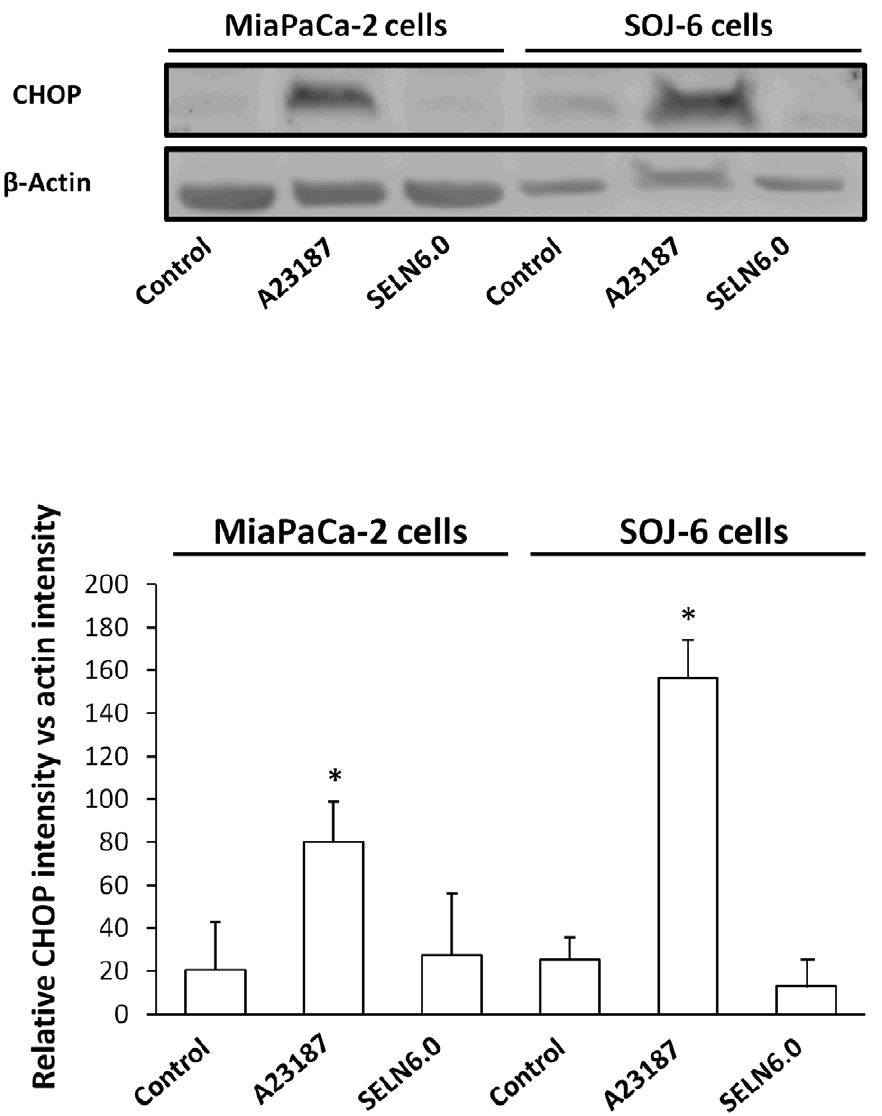
Figure 7. SELN cholesterol and UPR response. MiaPaCa2 and SOJ-6 cells were starved then incubated for 24h in the presence of the UPR inducer calcium ionophore A23187 (2.5 m g/ml), in the presence of SELN6.0 (16 nmoles cholesterol/ml) and in the absence of effector (control). At the end of the incubation cells were lysed and proteins were separated on SDS-PAGE (100 m g of proteins/lane) and electrotransferred onto nitrocellulose membrane. After saturation, membranes were incubated with primary antibodies to CHOP or b -actin and with the POD-labelled antibodies to mouse IgG. The upper part displays a typical western blotting, the lower diagrams are averages of western blotting quantification ( 6 SD) of three independent experiments (Mann-Whitney test).